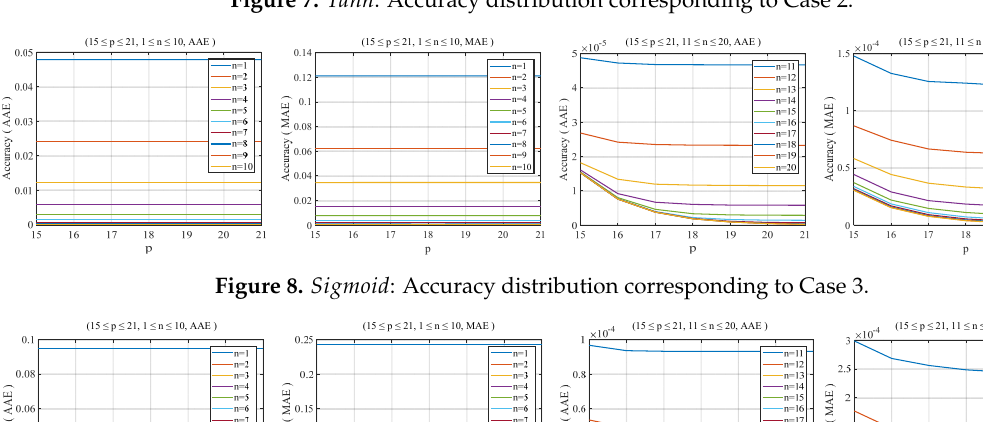
Figure 7. Tanh : Accuracy distribution corresponding to Case 2.